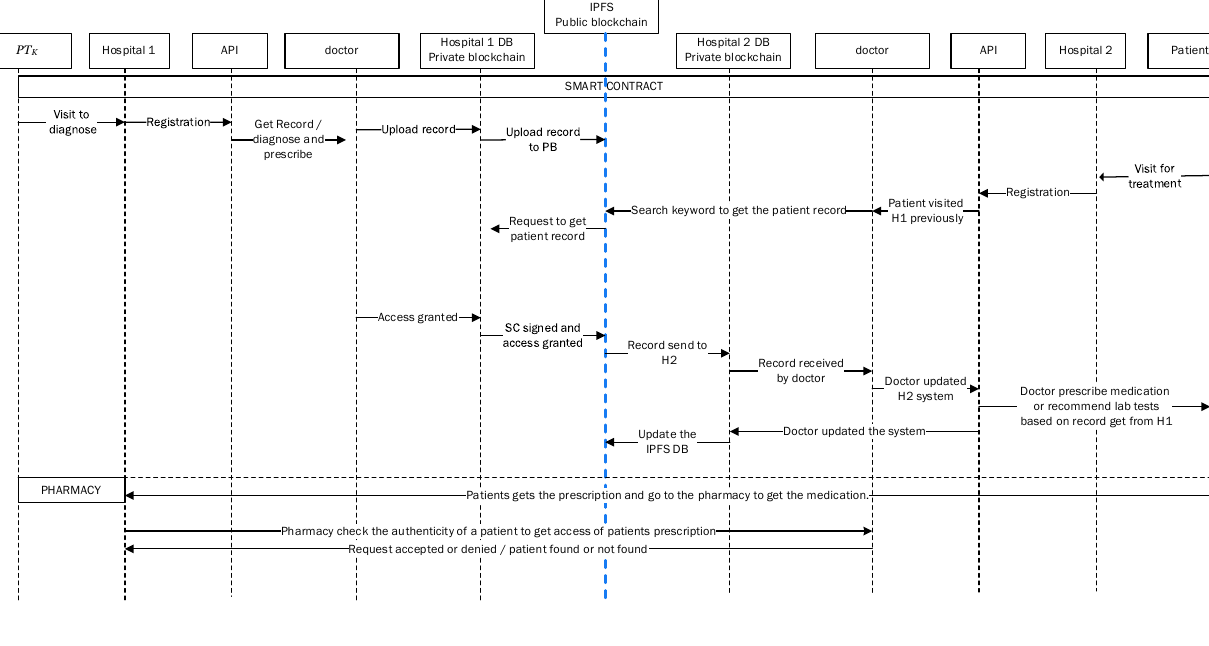
Figure 7. BlockPres transaction